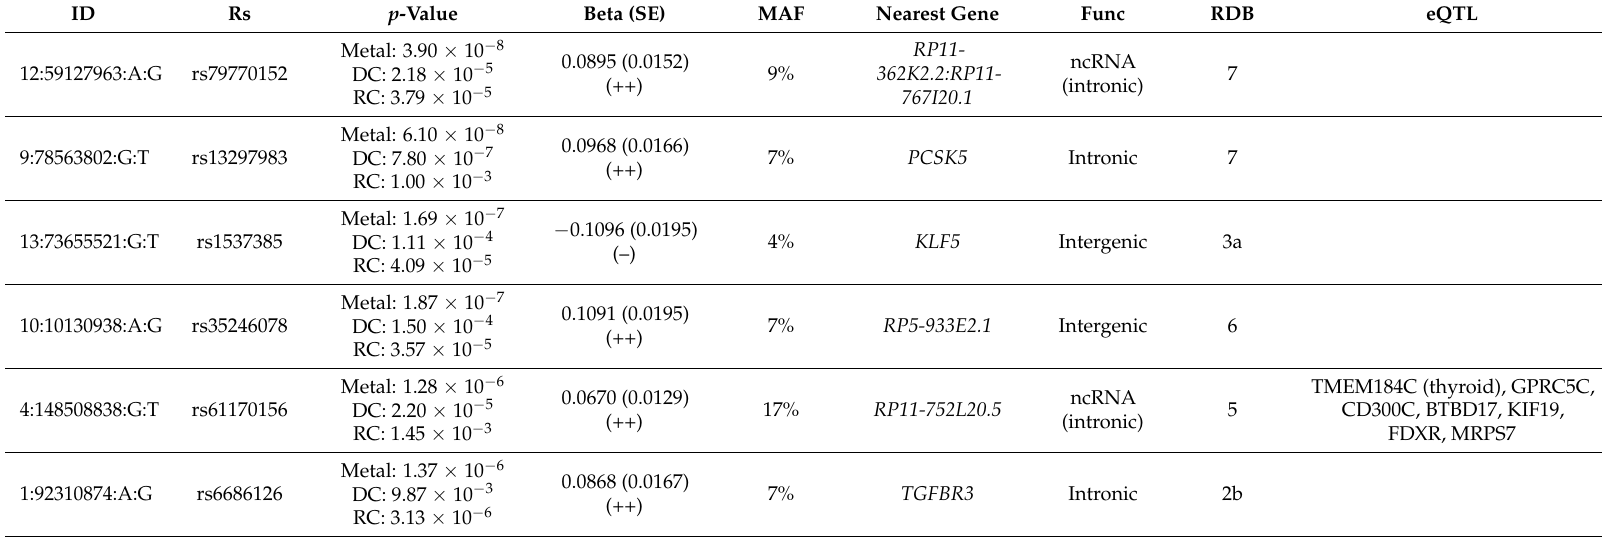
Table 5. The ten genomic loci with its leading